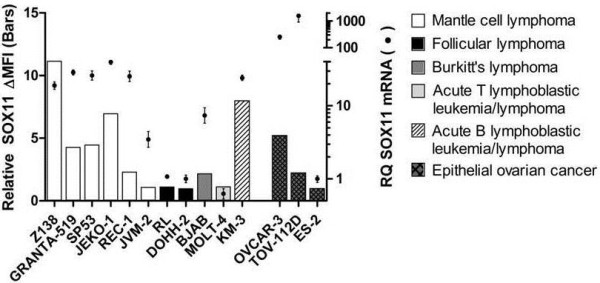
Flow cytometry-based assessment of SOX11 status in cell lines. Assessment of SOX11 status using flow cytometry analysis (bars) of B cell lymphoma and EOC cell lines reveal specific staining in cell lines positive for SOX11, including Z138, GRANTA 519, SP53, JEKO-1, REC-1, BJAB, KM3, OVCAR-3 and TOV-112D as assessed by RT-PCR analysis (diamonds). For each cell line, SOX11 ΔMFI was calculated as the difference between the mean fluorescence intensity (MFI) from SOX11-C1 antibody and the MFI from the control. (MFISOX11 – MFIcontrol). The relative SOX11 expression was calculated by scaling all data to the cell line with the lowest ΔMFI (DOHH-2).